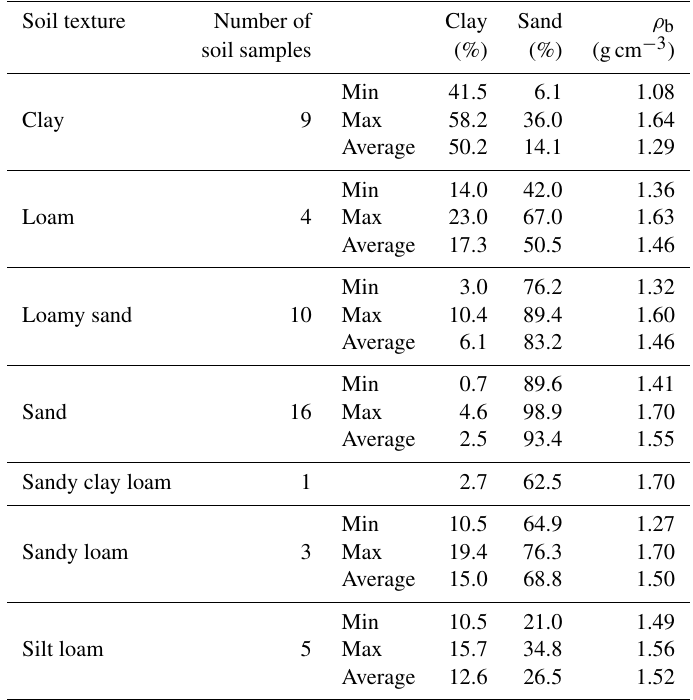
Table 2. Basic soil properties of 48 samples for the model